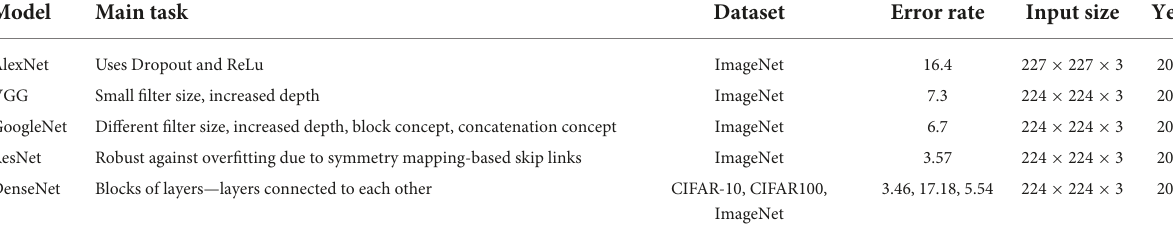
TABLE 2 Most used Convolutional Neural Network (CNN)